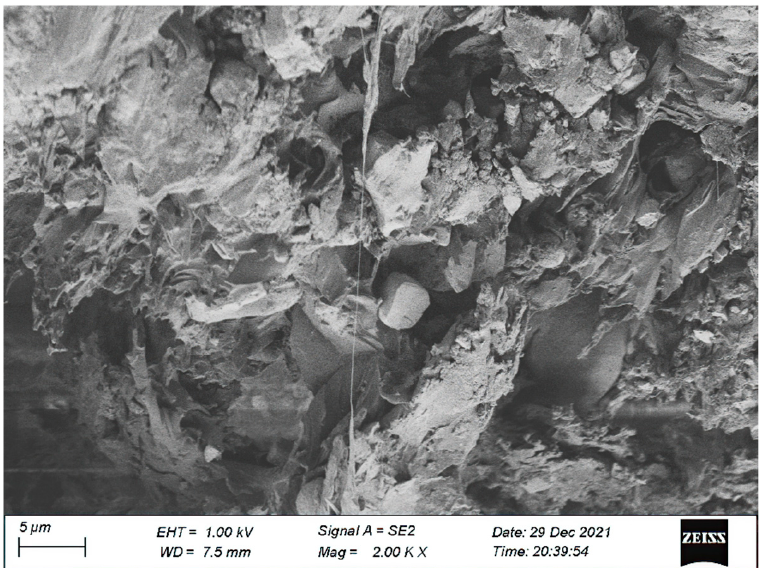
Figure 19. A 10 μ m SEM micrograph.